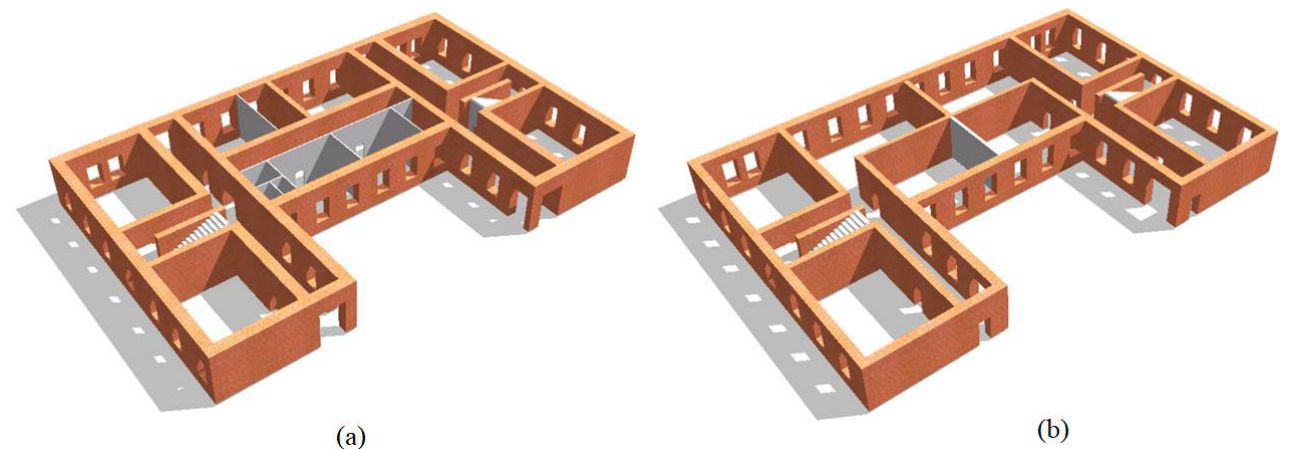
Figure 8. 3D models of: ( a ) the ground floor; ( b ) the first floor.